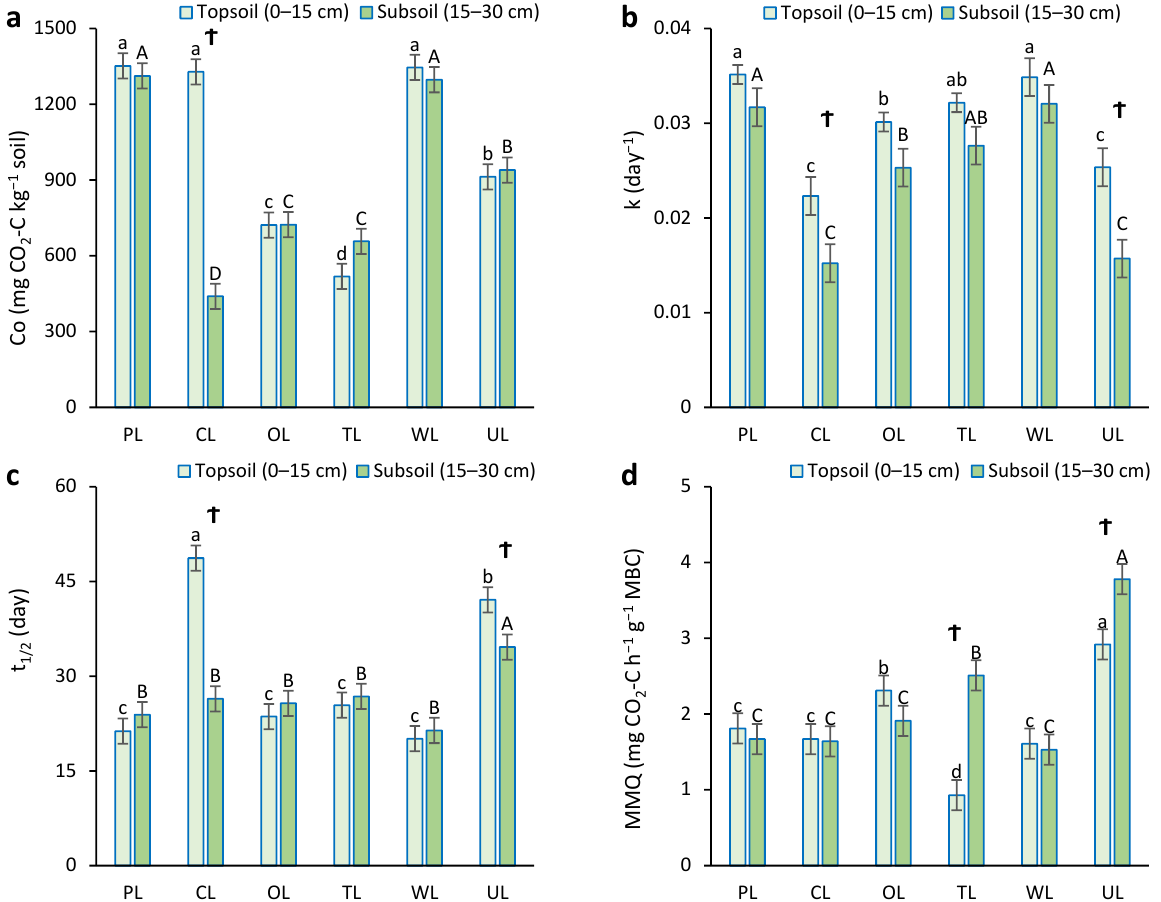
Figure 4. Soil microbial activity parameters influenced by different land uses in two depths. ( a ) C o : potentially mineralizable carbon; ( b ) k: constant of carbon mineralization; ( c ) t 1/2 : half-life time of carbon; ( d ) MMQ: microbial metabolic quotient. PL: pastureland; CL: cropland; OL: orchard land; TL: tea land; WL: woodland; UL: uncultivated land. Lowercase letters indicate the mean comparison between land uses in topsoil (0 – 15 cm). Uppercase letters indicate the mean comparison between land uses in subsoil (15 – 30 cm). Ϯ shows a significant difference between the two depths for one land use.